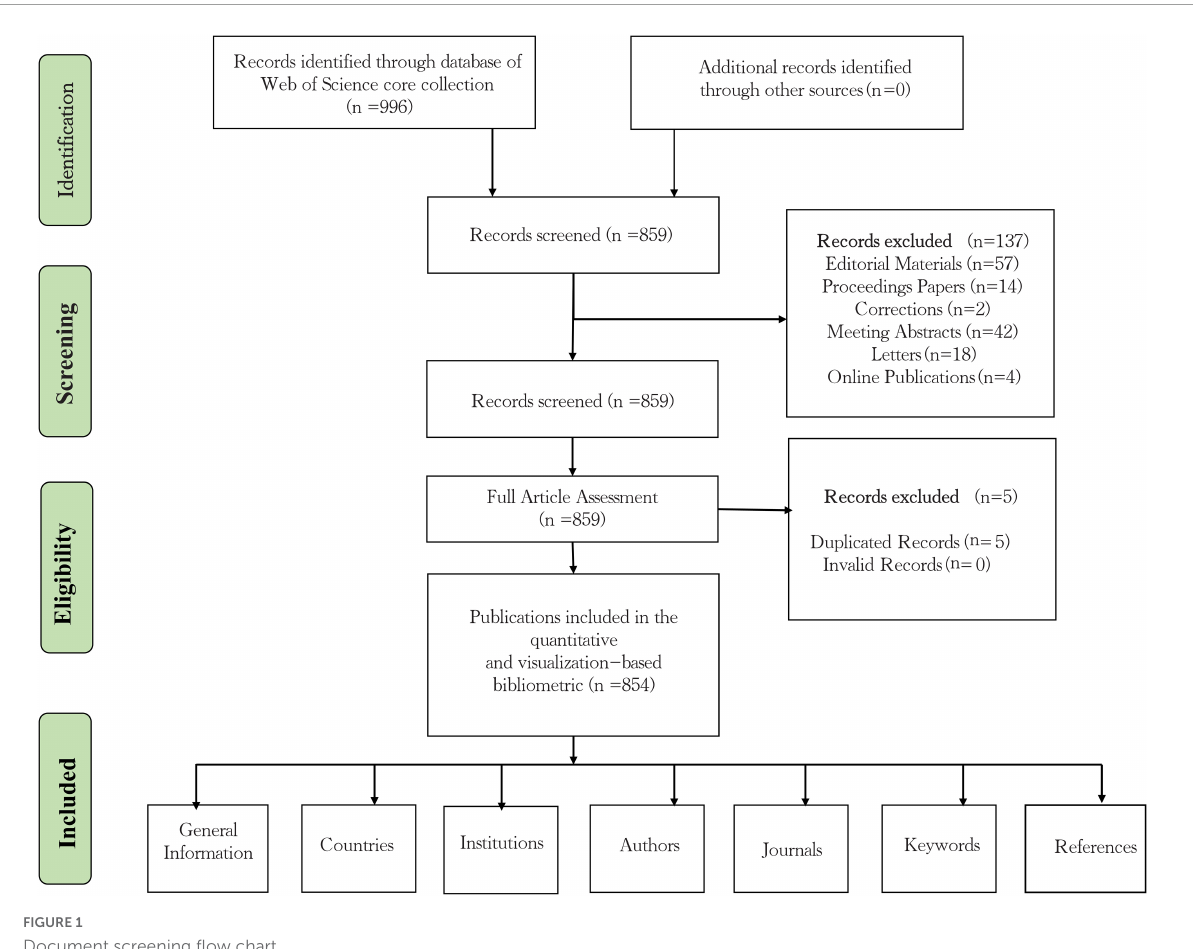
FIGURE1 Document screening flow